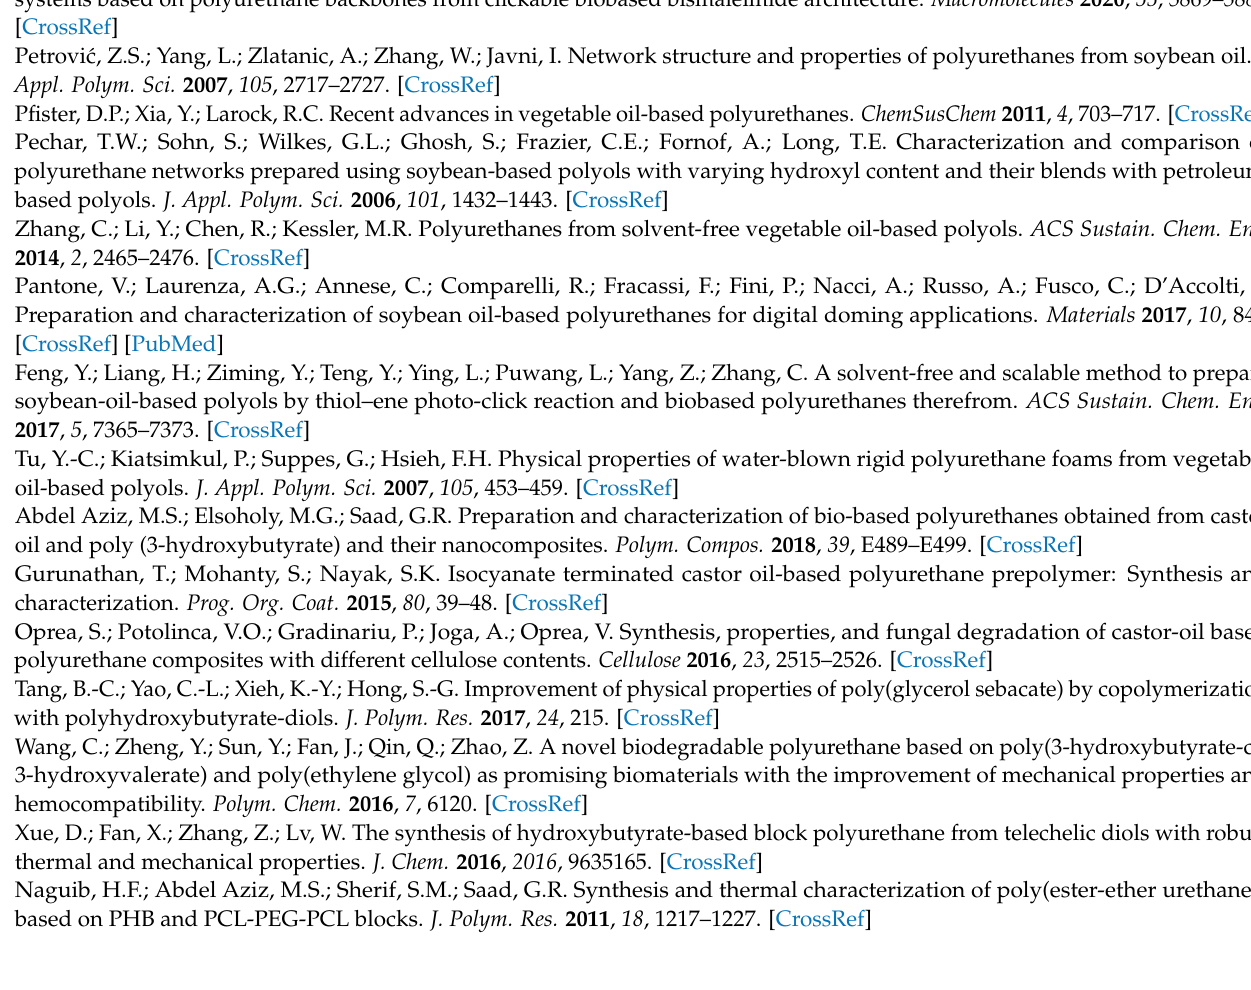
Figure S1: 1 HNMR spectra of PHB diols obtained from different timed reactions; Figure S2: SEM images of CO PU (a) and CO/PHBD PU 8h with NCO/OH 2.0 (b) and 4.0 (c); Figure S3: Solubility test of CO/PHBD PUs in water and chloroform; Figure S4: FTIR spectra of different CO/PHBD PUs; Figure S5: SEM analysis of CO/PHBD PUs after 35 days soil burial